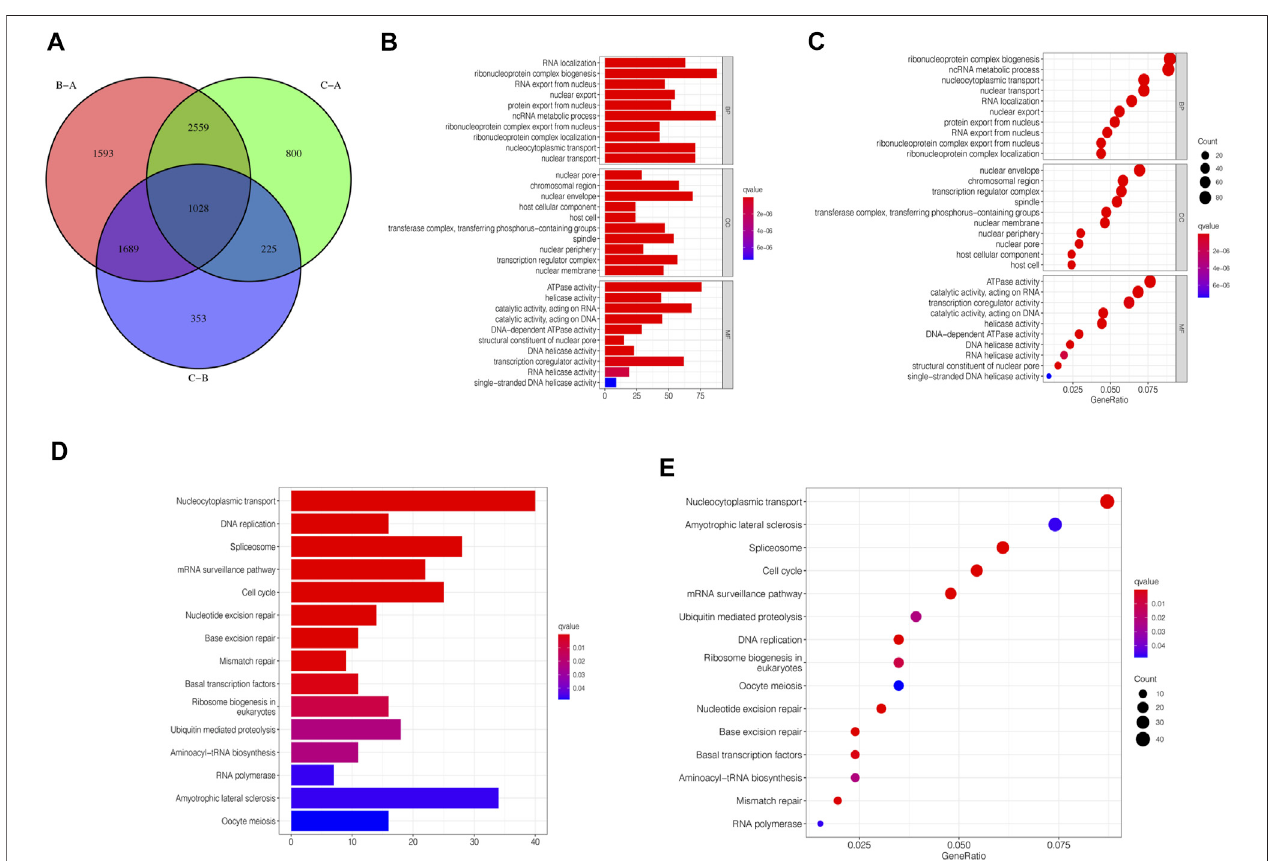
FIGURE 4 | m6A-related genes ’ functional annotation. (A) 1028 m6A-related DEGs between three m6A clusters are shown in the Venn diagram. (B) Functional annotationfor m6A-relatedgenesusing GOenrichmentanalysison thebar chart. (C) Functional annotationfor m6A-related genesusing GO enrichment analysison the bubble chart. (D) Functional annotationfor m6A-related genesusing KEGG enrichmentanalysison thebar chart. (E) Functional annotation form6A-relatedgenesusing KEGG enrichment analysis on the bubble chart.